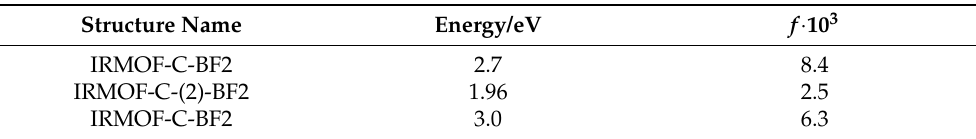
Table 12. Topological parameters of the BCP of bond in adsorption configurations of guest molecules (CO 2 and H 2 ) on